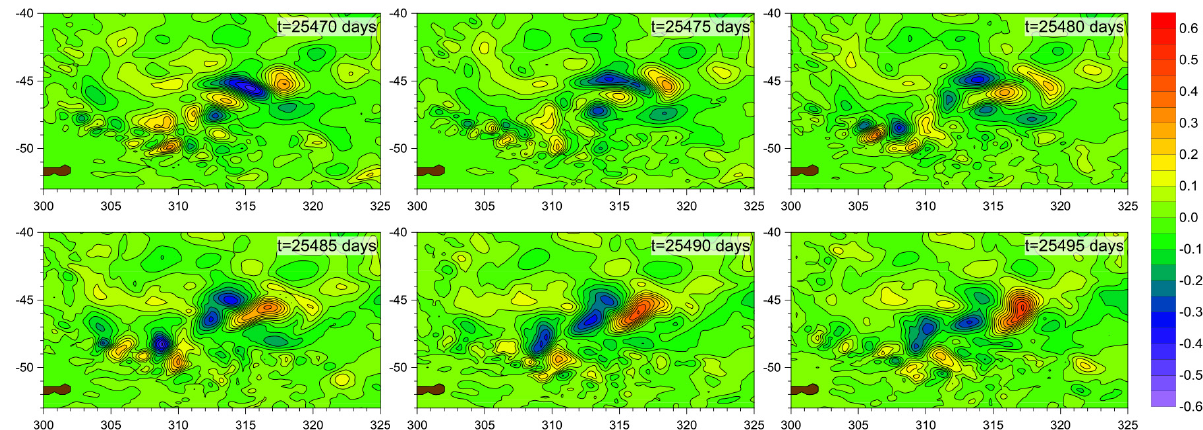
Fig. 14. Snapshot sequence of the SSH high-frequency residual (in m) corresponding to a high-frequency maximum of the wavelet amplitude at P3 (see the oval in Fig. 13b).